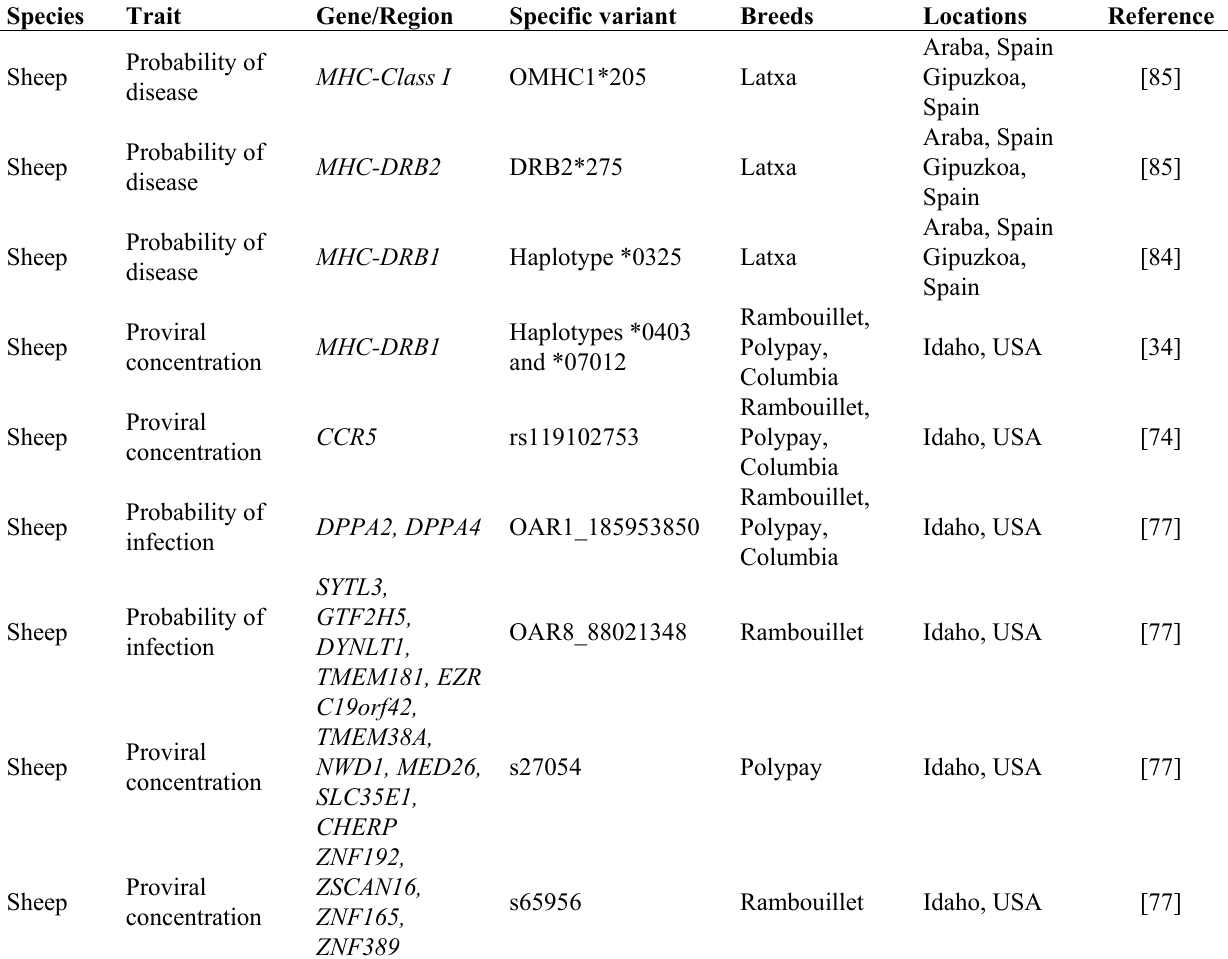
Table 4. Genetic variants with reported initial associations for small ruminant lentivirus